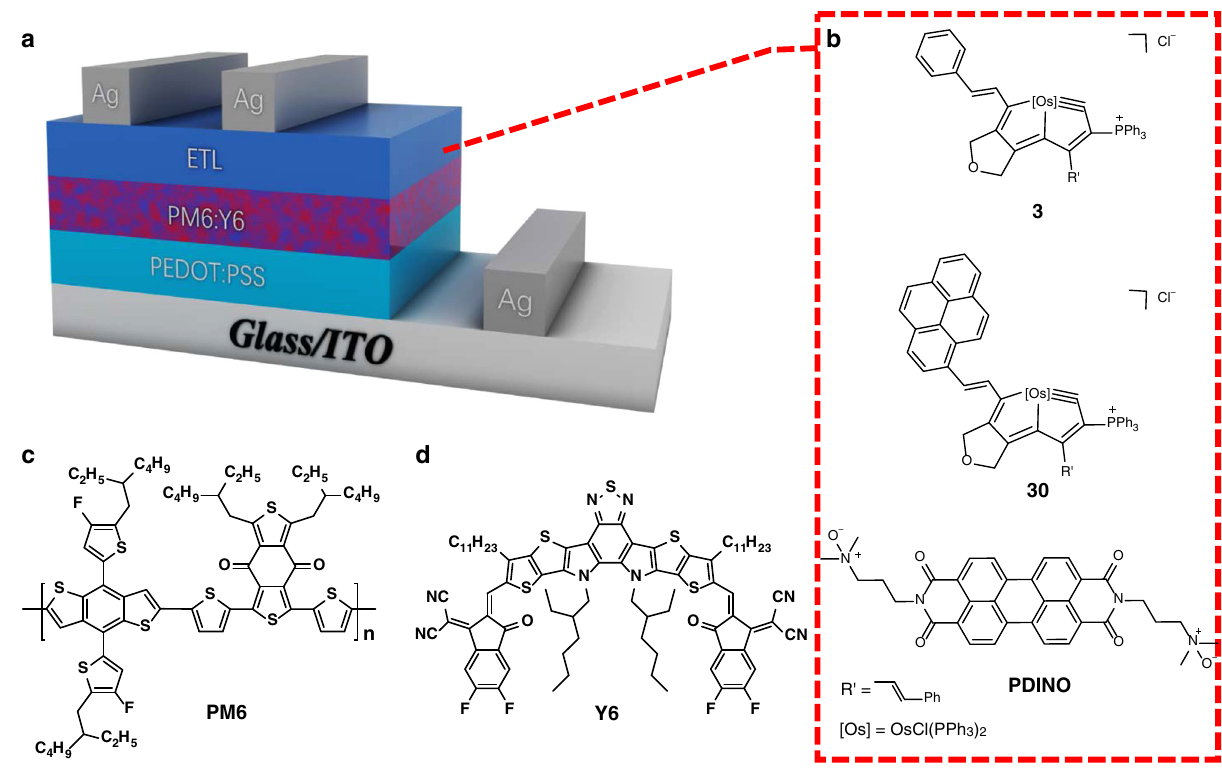
Fig. 6 Applications in organic solar cells. a Conventional structure of photovoltaic devices and chemical structures of ( b ) various molecules used as electron-transport layers (ETLs). c Polymer donor PM6. d Non-fullerene acceptor